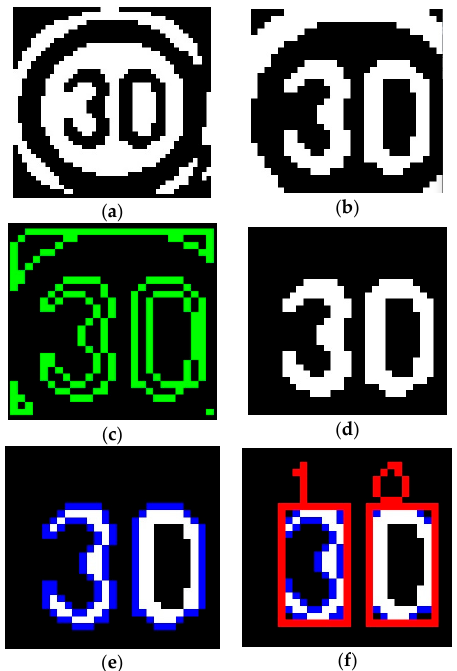
Figure 13. Detailed description of the processing used to extract the numbers on speed-limit signs. ( a ) Image following application of a variable average binarization processing to the grayscale image of the detected speed-limit sign; ( b ) Image with central area of image ( a ) extracted and black/white reversed; ( c ) Contours image of boundary between white areas and black areas in image ( b ); ( d ) Number candidate area obtained from mask processing of image ( b ) using a mask image obtained by using contours image ( c ); ( e ) Image following application of contour processing after dilation-erosion (closing) processing of the number candidate areas to eliminate small black areas inside the white objects; ( f ) Number image delivered to recognition processing when the contour area satisfies the aspect ratio of numbers.